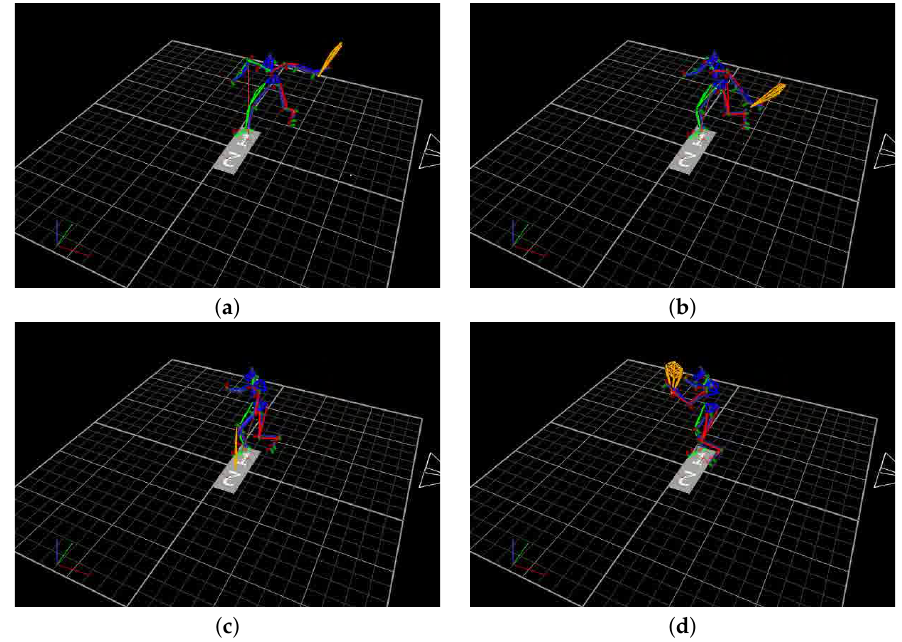
Figure 2. An example of raw forehand shot phases. ( a ) beginning of the preparation phase, ( b ) end of the preparation phase ( c ) hitting the ball and ( d ) swinging the racket after the